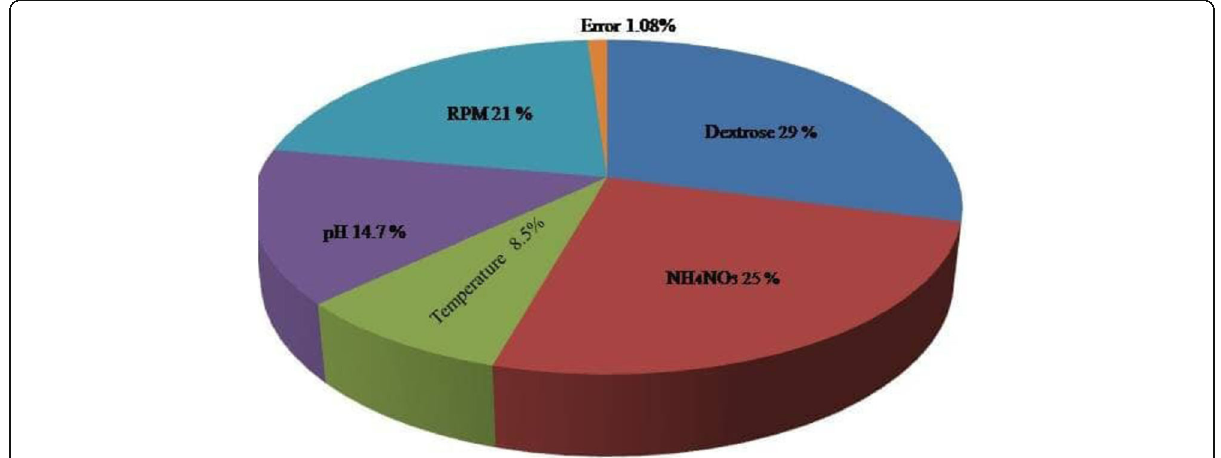
Fig. 3 Percentage of various factors contributing to overall